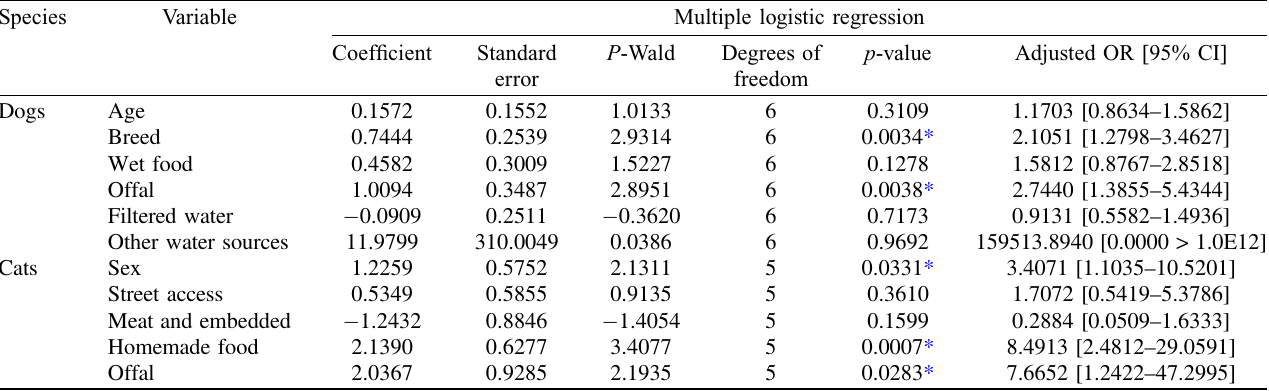
Table 3. Final models of logistic regression analysis from variables statistically ( p (cid:3) 0.05) associated factors with T. gondii infection